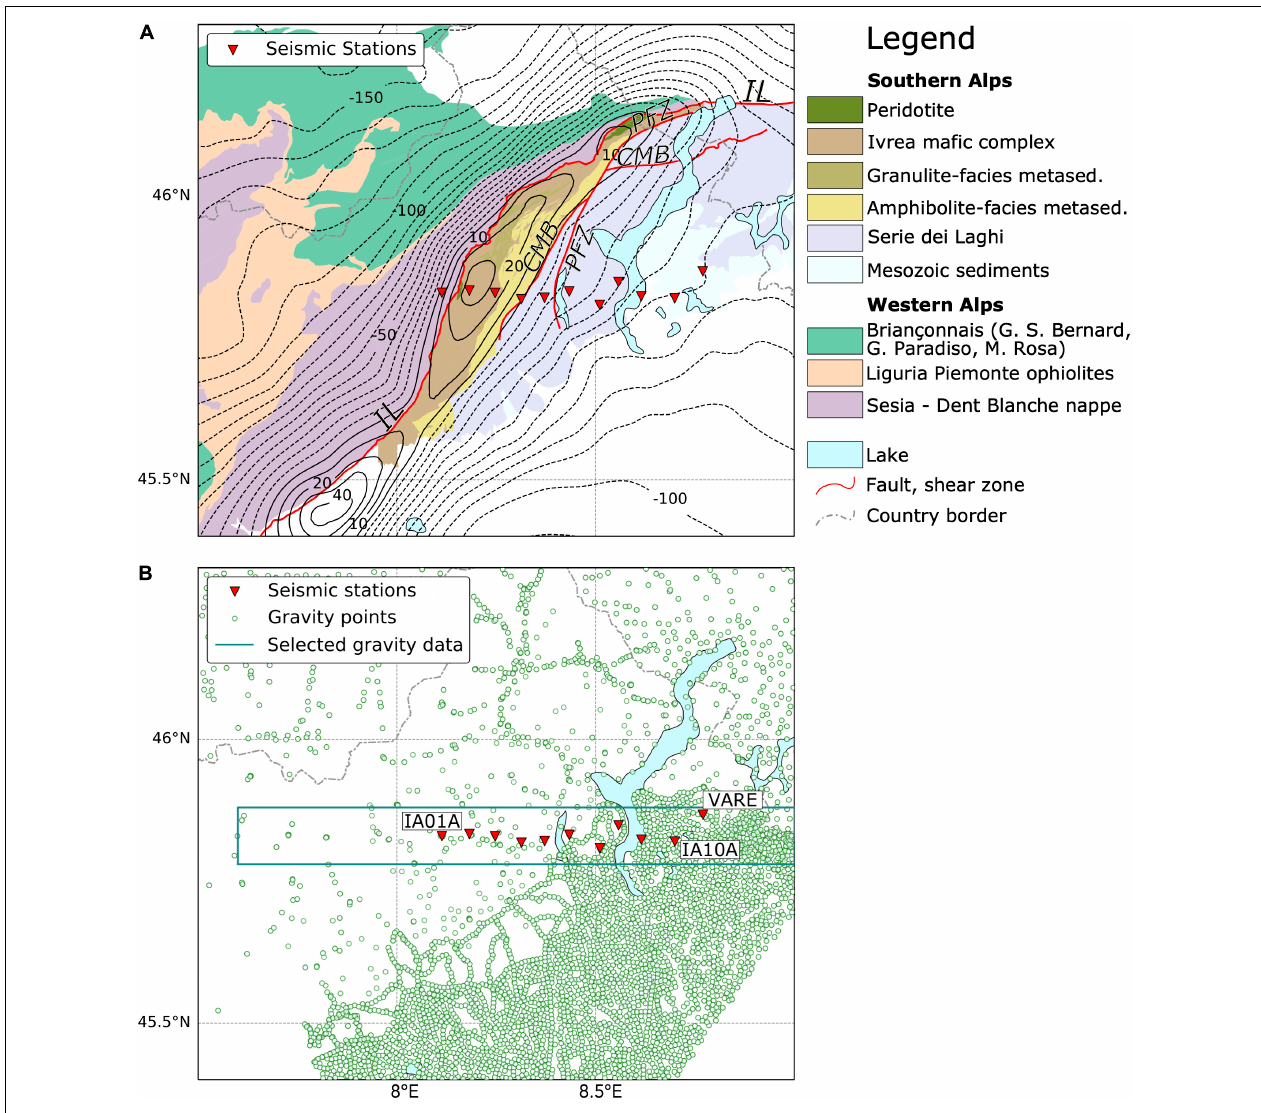
FIGURE 2 | (A) Geological map of the IVZ and the surrounding areas, simplified from Petri et al. (2019) and Schmid et al. (2004) (see legend on the right hand of the figure), together with the location of the 10 IvreaArray broadband seismic stations and the INGV permanent seismic station IV.VARE [red triangles, see station names in (B) ]. The main faults (red lines), relevant for this study, are indicated as “IL” for Insubric Line, “PFZ” for Pogallo Fault Zone and “CMB” for Cossato-Mergozzo-Brissago Line. Overlaid, the 10 mGal contour lines for the Bouguer gravity anomaly from our data across the study area. (B) The compiled gravity data set for this study is shown (green circles), which comprises earlier existing gravity data and recently collected gravity data in the scope of the work of Scarponi et al. (2020). The location of the IvreaArray seismic stations is shown (red triangles) together with the INGV permanent seismic station IV.VARE and their names. The cyan box indicates the gravity data we selected for this study along the 2D IvreaArray profile. The dashed-pointed gray line indicates the Swiss-Italian border as shown in the